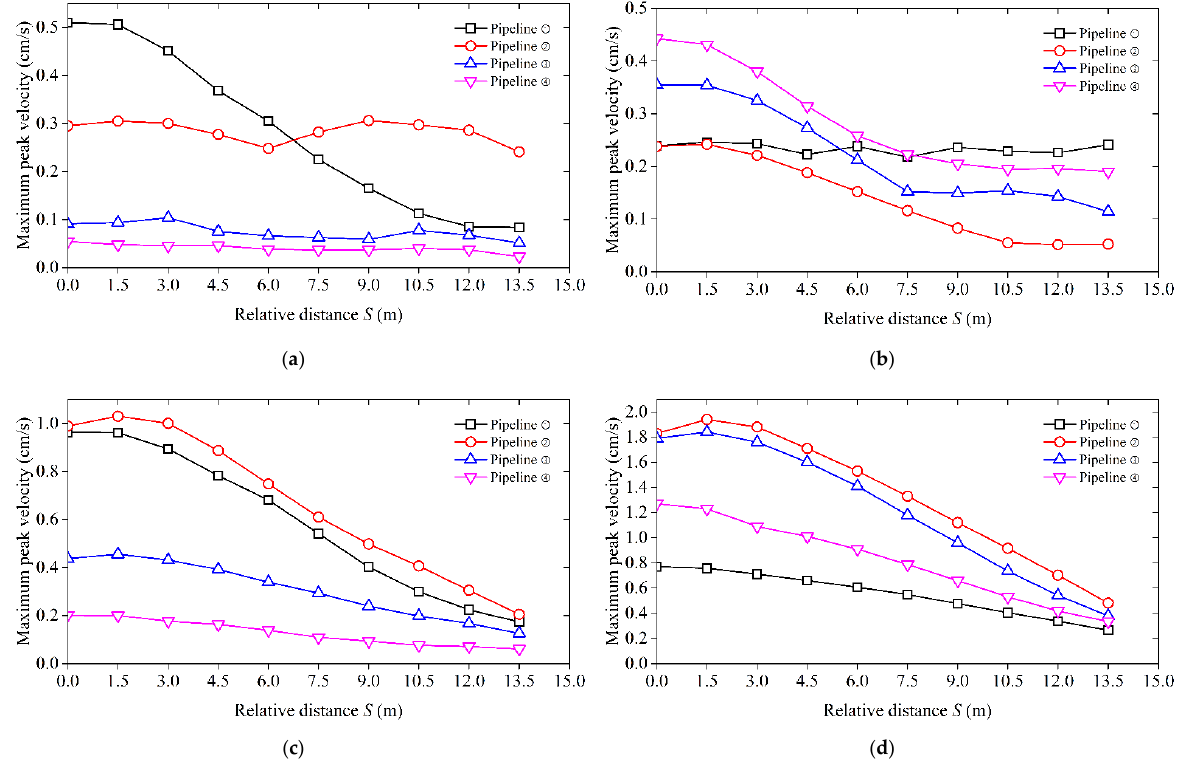
Figure 12. Dynamic responses of existing pipelines induced by blasting the pilot tunnels: ( a ) 1st pilot tunnel; ( b ) 2nd pilot tunnel; ( c ) 3rd pilot tunnel; ( d ) 4th pilot tunnel.